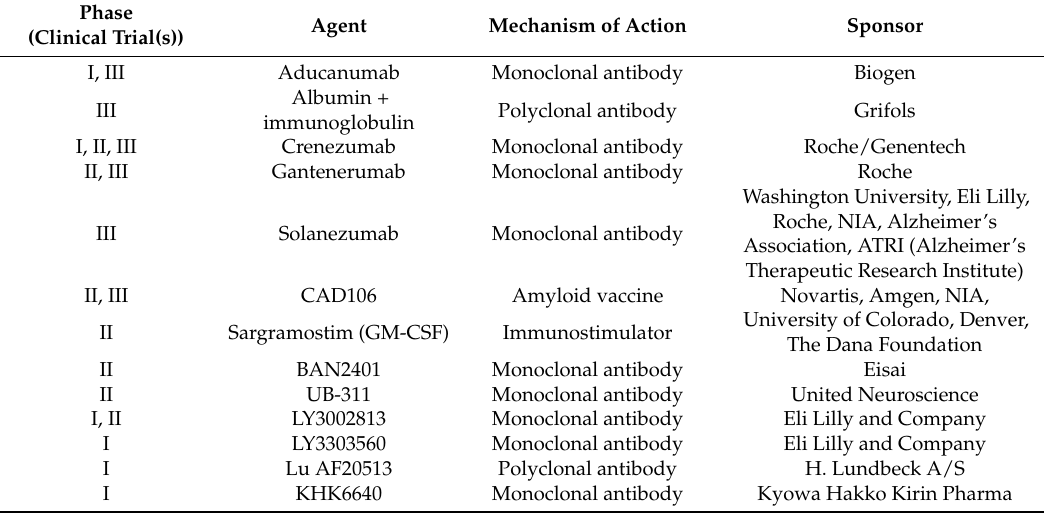
Table 2. Immunotherapeutic agents (amyloid related) in the AD pipeline (2018). Phase (Clinical